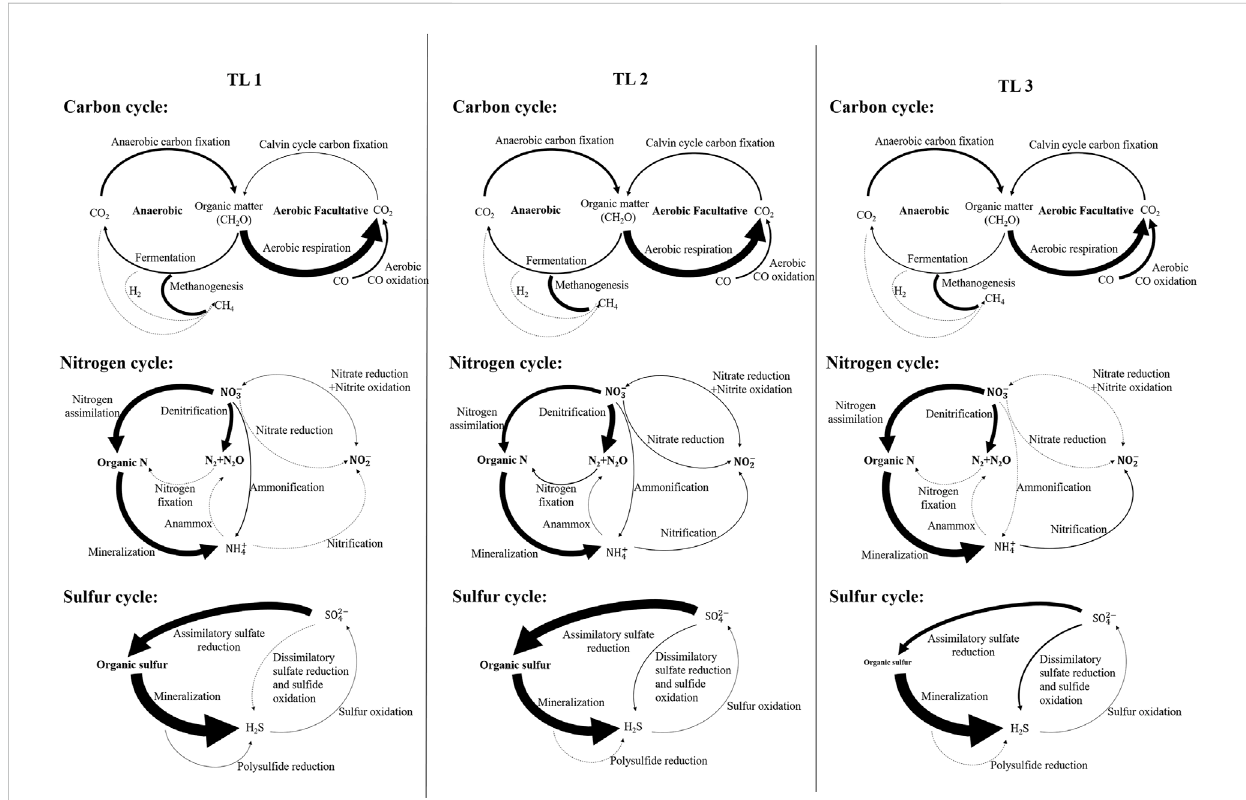
FIGURE 4 Schematic diagram of metabolic potential of lakes in each terrain ladder participating in carbon, nitrogen and sulfur cycles. Width of arrow is proportional to the relative metabolic potential of the pathways (100% values of each cycle, see Supplementary Table S4). Dotted lines indicate that marked genes were not